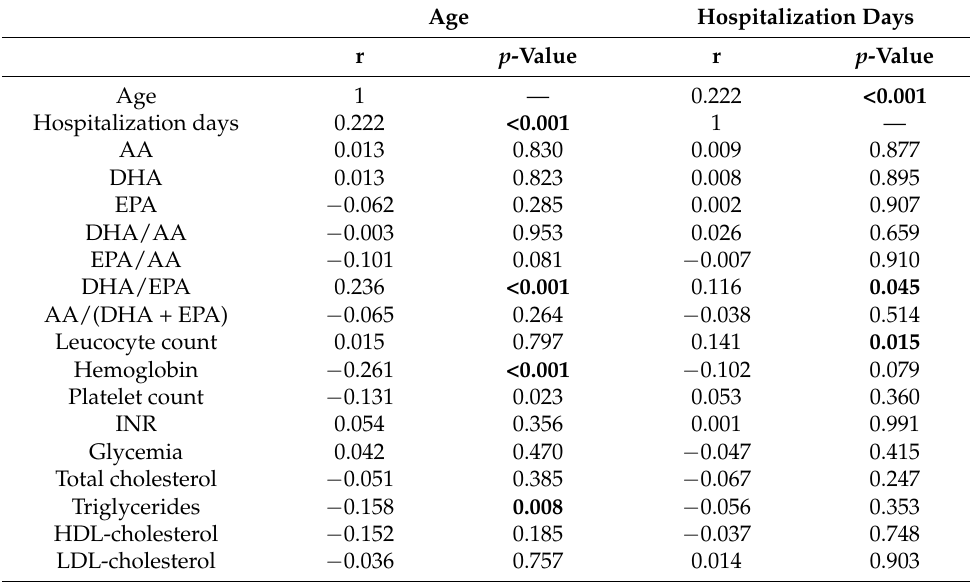
Table 8. Pearson correlations between paraclinical and clinical